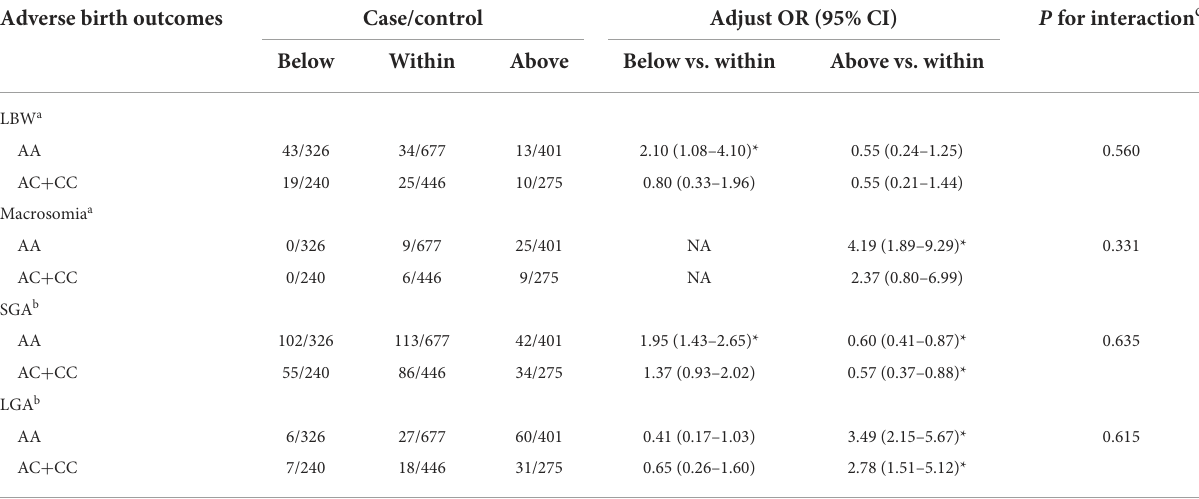
TABLE 3 Associations of GWG categories and adverse birth outcomes stratified by MTHFR A1298C polymorphisms. Adverse birth outcomes Case/control Adjust OR (95% CI) P for interaction c Below Within Above Below vs. within Above vs. within